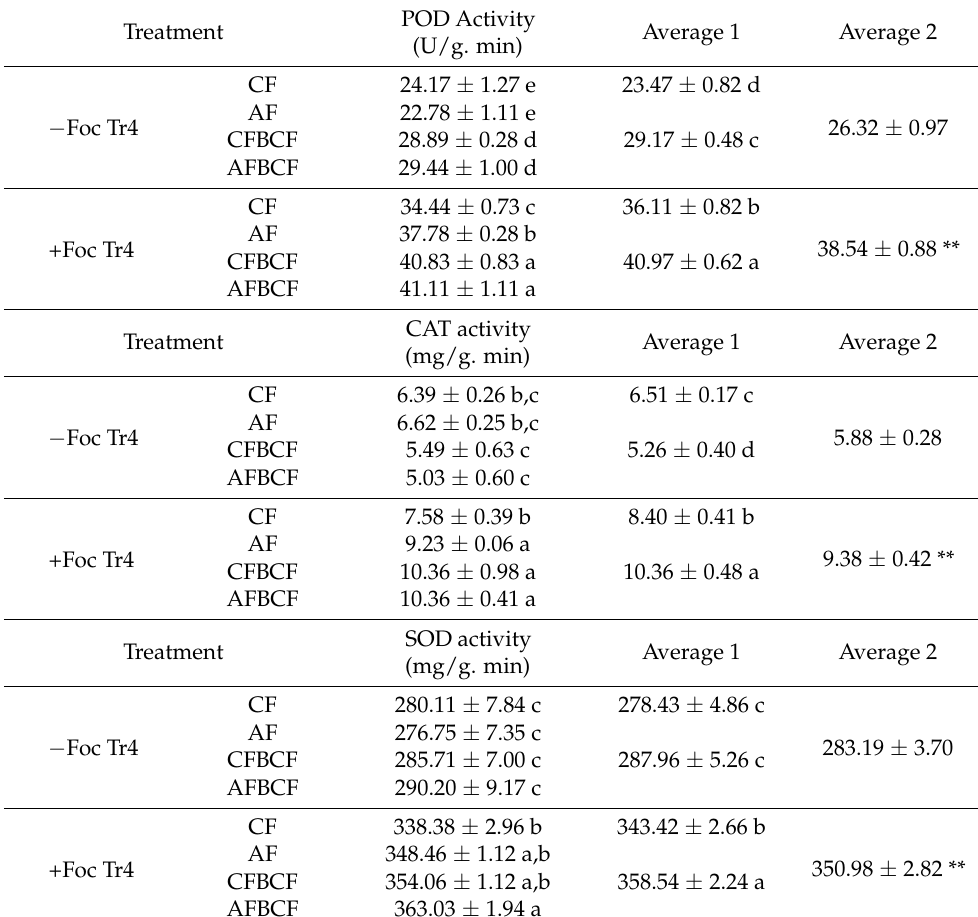
Table 3. Effect of alkaline fertilizer and biocontrol fungi on antioxidant enzyme activities of ba- nana